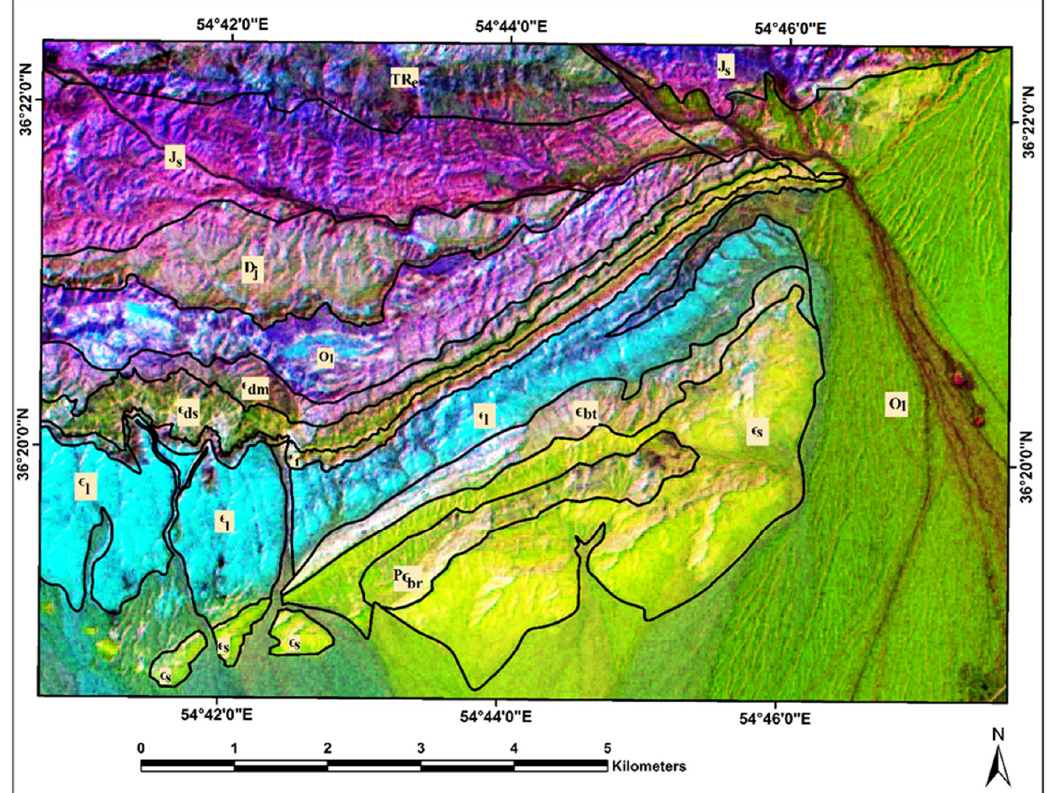
Figure 8. RGB Color composite of BRTM PC1, PC2, PC3 for the Deh-Molla region. Qal, Quaternary alluviums; Js, Shemshak Formation; TRe, Elika Formation; Dj, Jeirud Formation; Ol, Lashkarak Formation; Єdm, Deh-Molla Formation; Єds, De-Sufian Formation; Єf, Fasham; Єl, Lalun; Єz, Zagun Formation; Єbt, Barut Formation; Єs, Soltanieh Formation; PЄbr, Bayandor Formation.